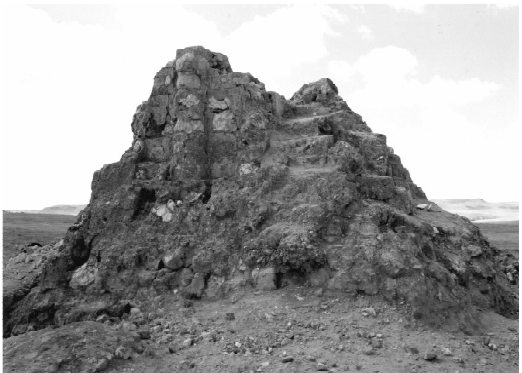
Figure 4. The ruined Tower H 21 at Tabus on Jebel Bishri. Photo from W: E. Seland 2004.